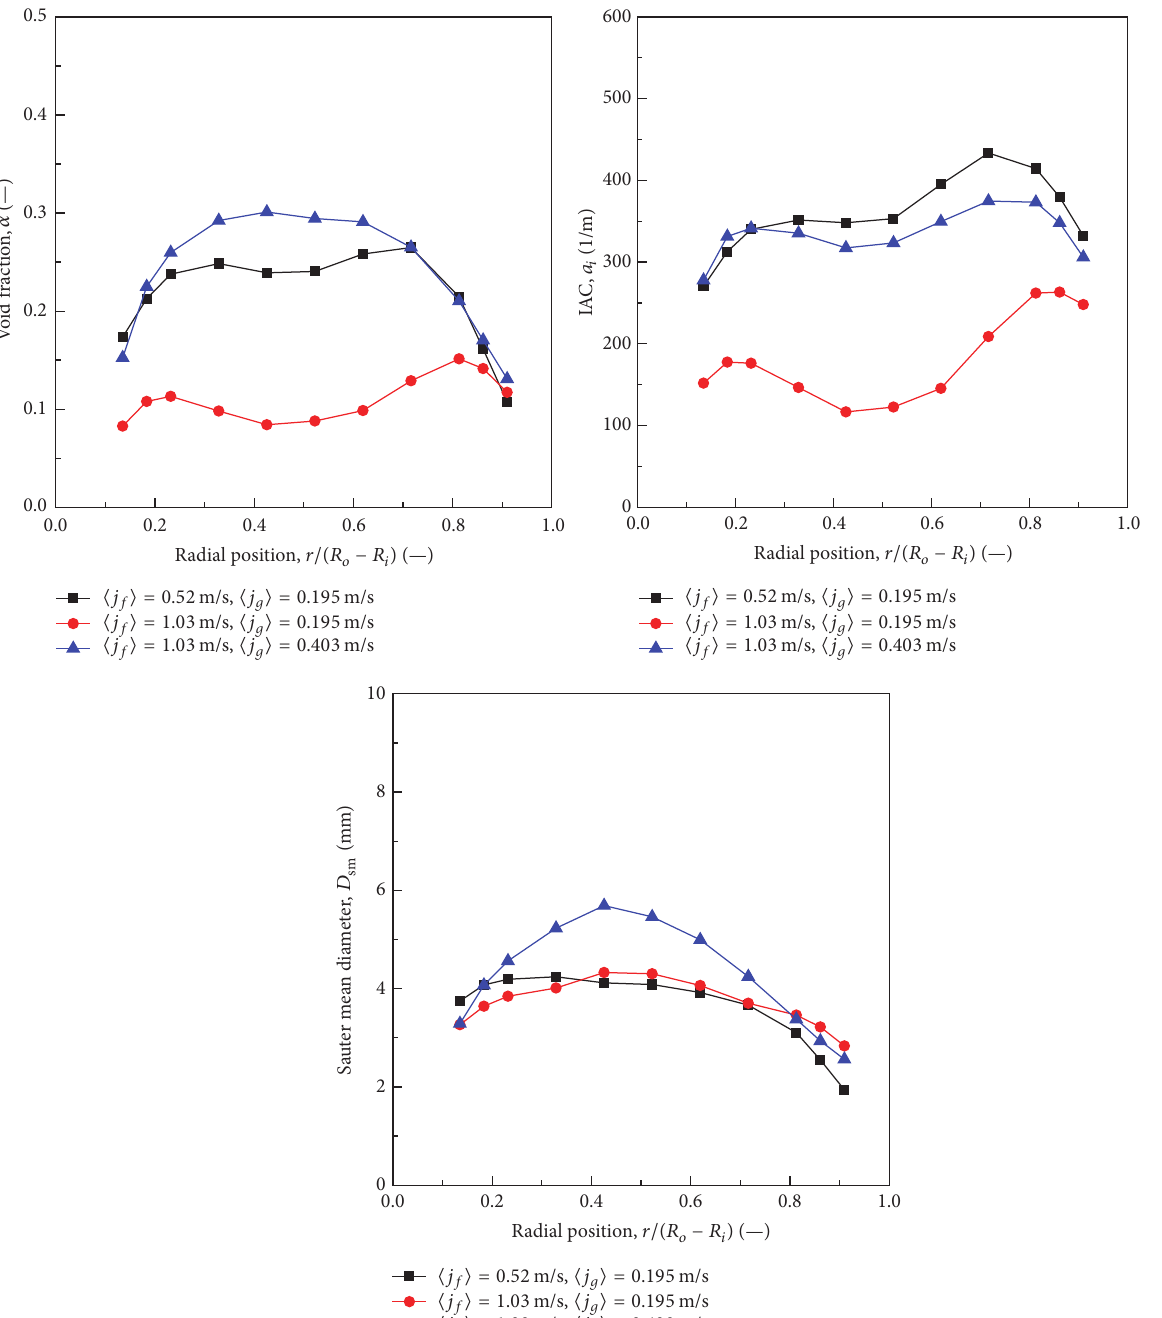
Figure 4: Profiles of local time-averaged flow parameters under static